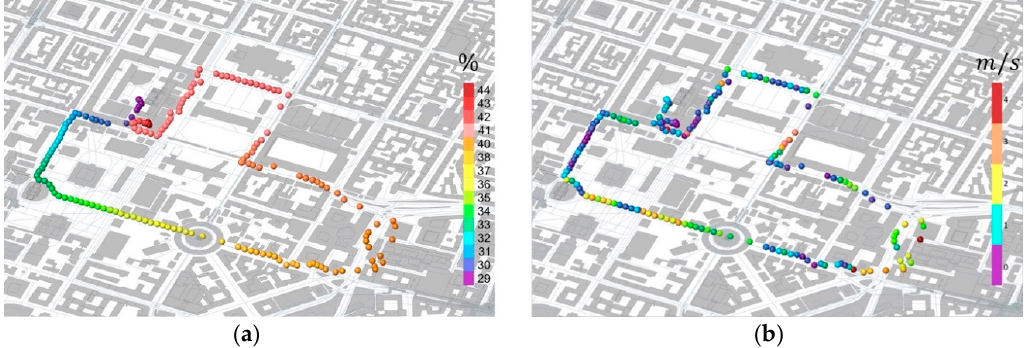
Figure 26. Transient temperature maps: ( a ) globe temperature (°C); ( b ) air temperature (°C). ISPRS Int. J. Geo-Inf. 2019 , 8 , 76